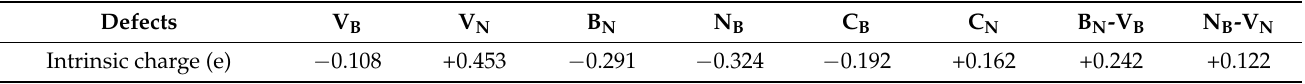
Figure 7. Charge transfer of neighboring atoms around charged defects. ‘+’ and ‘ − ’ denote absorbing and losing electrons during doping, respectively. ( a ) V B , ( b ) V N , ( c ) B N , ( d ) N B , ( e ) C B , ( f ) C N , ( g ) B N -V B , and ( h ) N B -V N. Table 1. Intrinsic charge of various defects in hBN